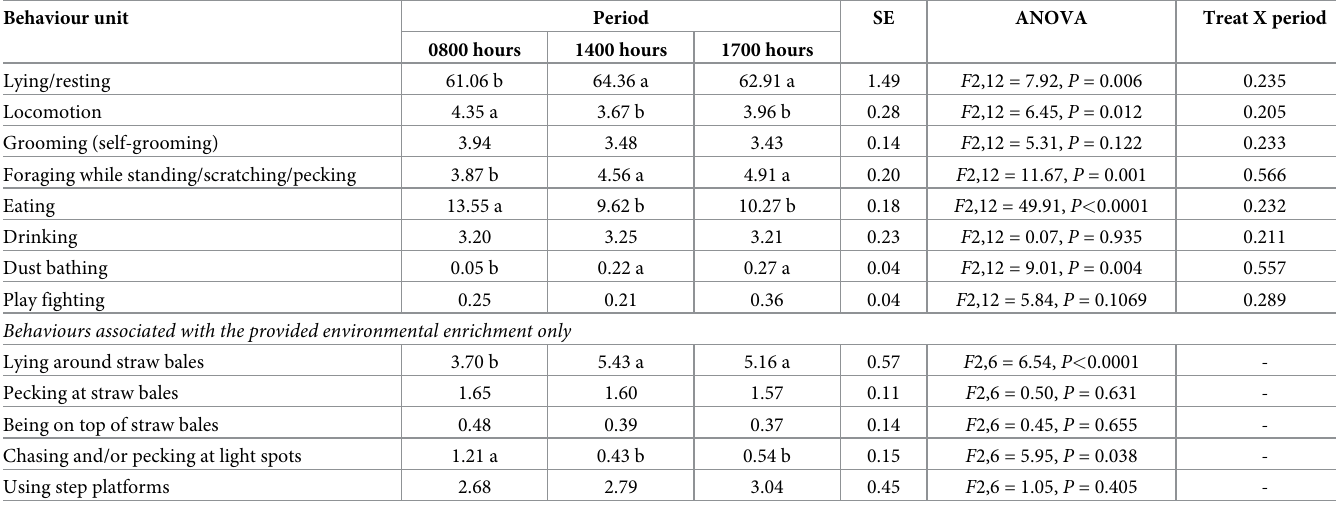
Table 4. Frequency (%) of each behaviour observed for broiler chickens as effects of time of day. Behaviour